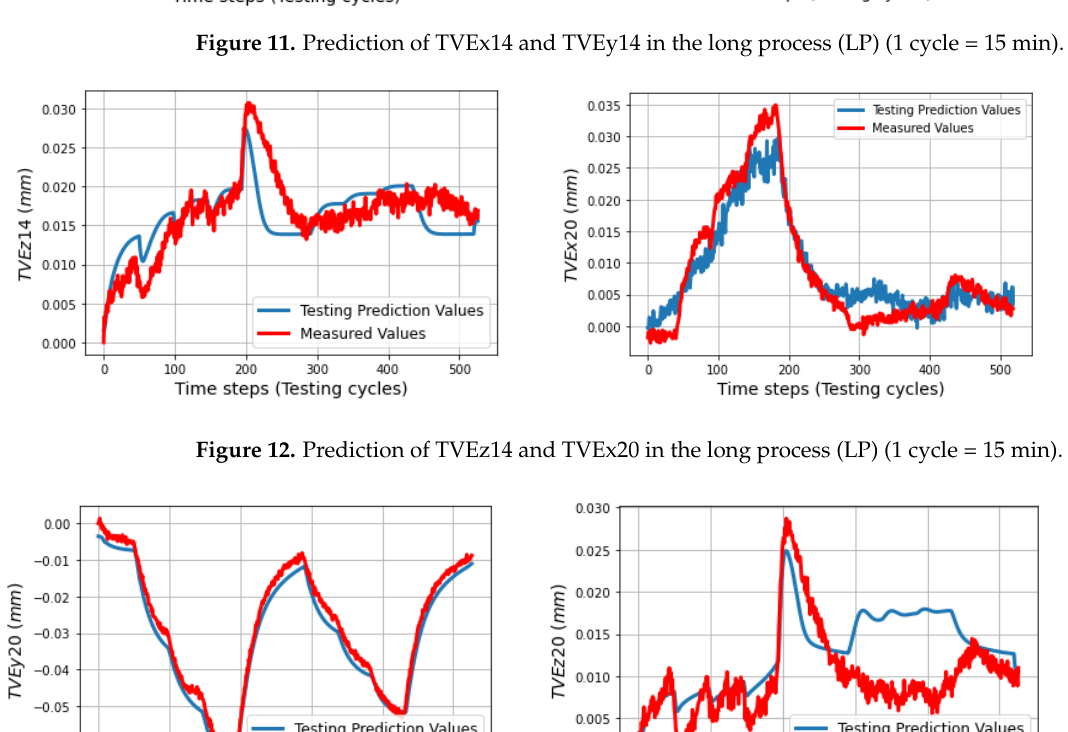
Figure 13. Prediction of TVEy20 and TVEz20 in the long process (LP) (1 cycle = 15 min).